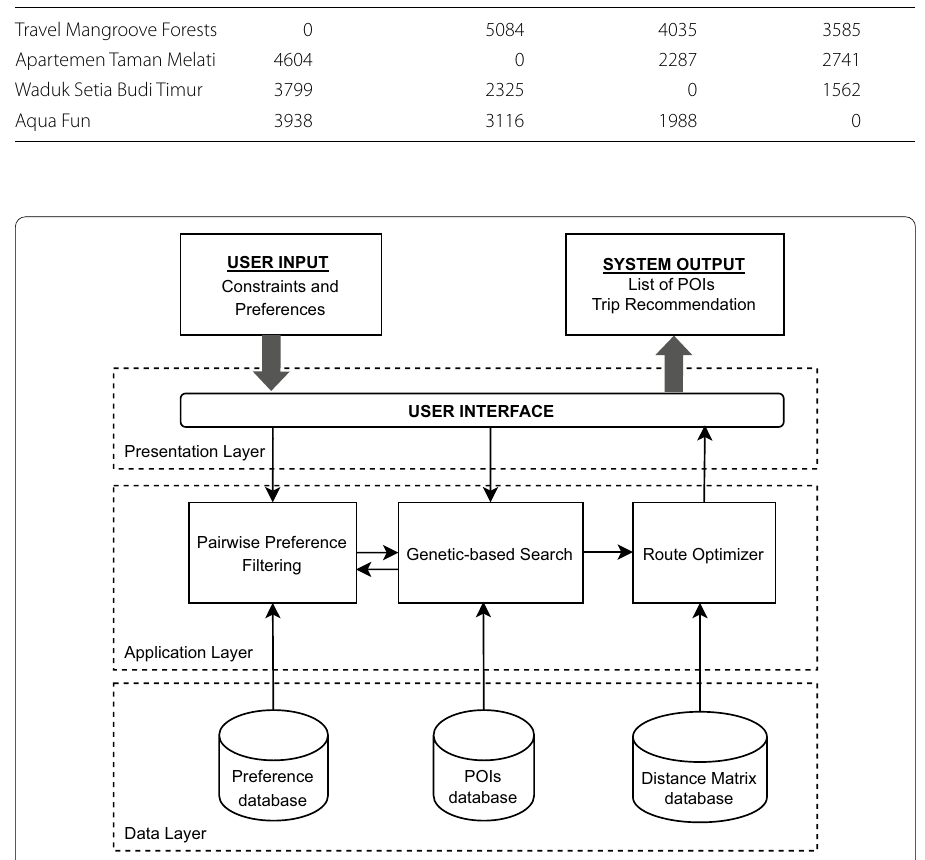
Fig. 1 Proposed recommender system